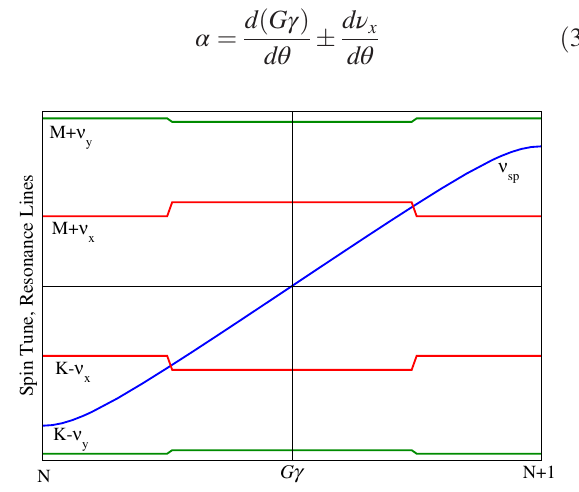
FIG. 1. The schematics of tune jump scheme. The blue trace is the spin tune as function of G γ during acceleration. The red lines are the horizontal intrinsic resonance lines. The green lines are vertical resonance lines. Over one unit of G γ , two horizontal intrinsic resonances are crossed. M, K, and N are